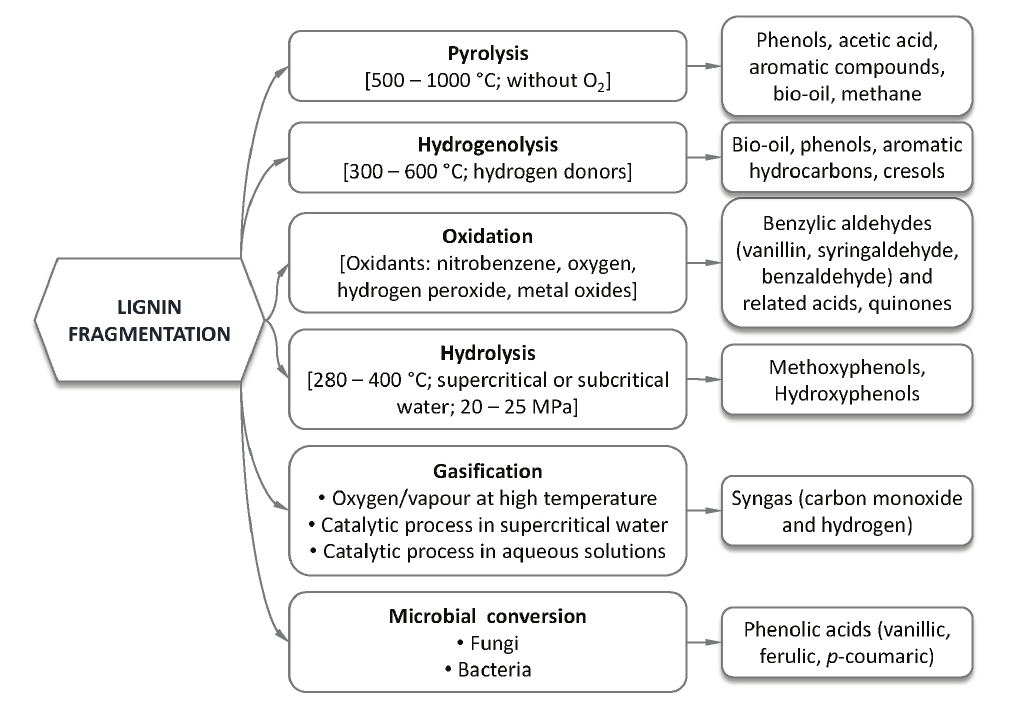
Fig. 5 – Most common processes of lignin fragmentation and potential bio-based